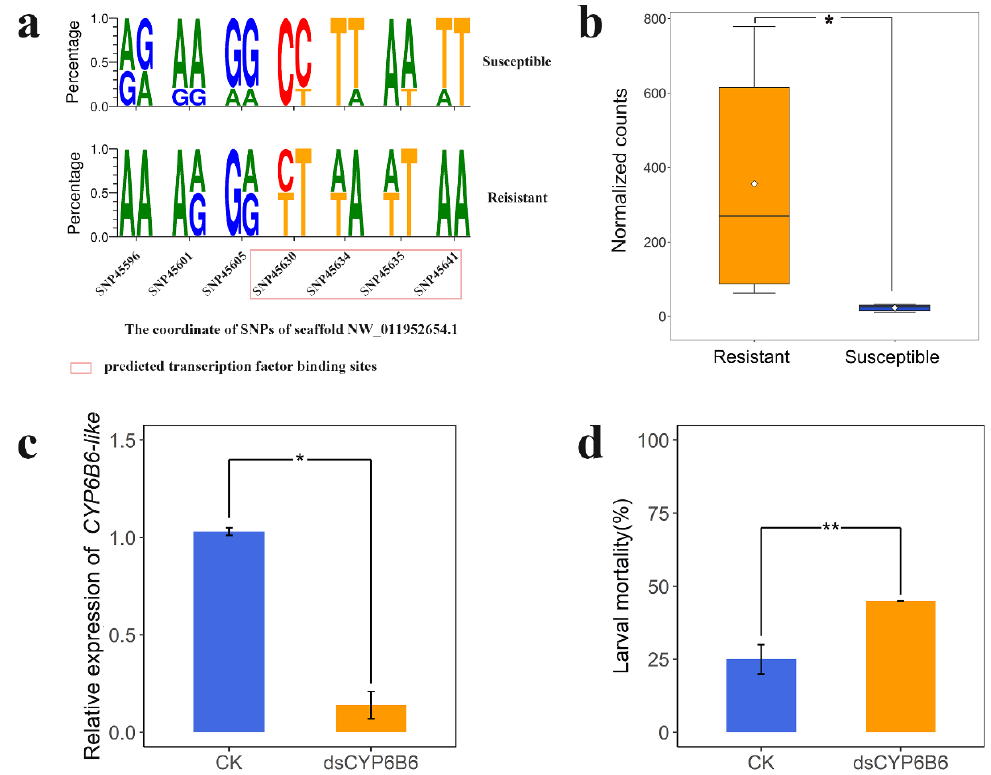
Figure 8. Functional analysis of CYP6B6-like ( LOC105395328 ). ( a ) The SeqLogo plots show the diploid genotypes’ frequency of potential transcriptional regulatory region of CYP6B6-like (2000 nt regions upstream of gene), which were significantly different between resistant strains and the susceptible strain. ( b ) The expression levels of CYP6B6-like in susceptible and resistant strains. Normalized counts: Counts normalized with DEseq2. * indicates significant influences (Student’s t test, P = 0.026, n = 6). ( c ) The expression levels of the CYP6B6-like were significantly reduced after 24 h dsRNA feeding. * indicates significant influences (Student’s t test, P = 0.037, n = 3). CK indicates individuals fed with elution solution. Bars indicate ± SD. ( d ) The mortality rate of Plutella xylostella third instar larvae treated with LC 50 concentrations of chlorantraniliprole (0.042 mg/L) after 72 h dsRNA feeding. ** indicates significant influences (Student’s t test, P = 0.0023, n = 3). Twenty individuals were used for each group. Bars indicate ± SD.